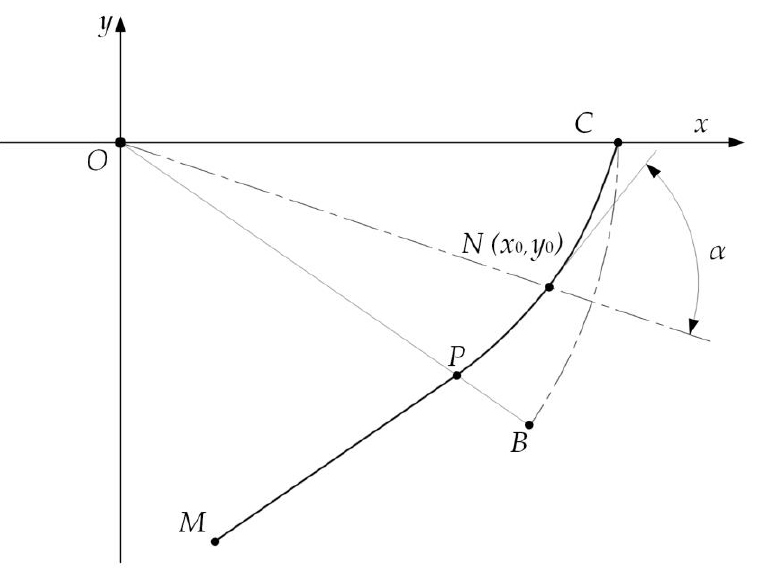
Figure 4. Analysis of FTP line shape.